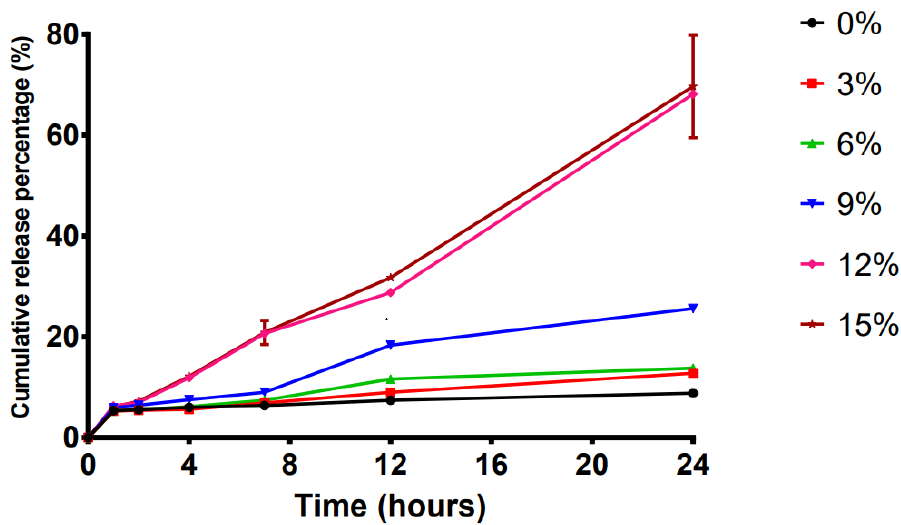
Figure 2. Effect of different concentrations of the oleic acid-azone compound on drug release in the LP-VPH compound transdermal drug delivery system (mean ± SD, n = 3).